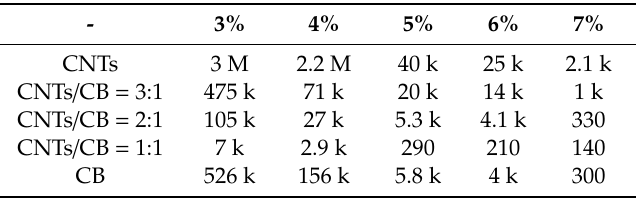
Table 1. Initial resistance of nanocomposites under different nanomaterial compositions and Table1. Initialresistanceofnanocompositesunderdi ff erentnanomaterialcompositionsandproportions. proportions. The unit is ohms ( Ω ). The unit is ohms ( Ω ).